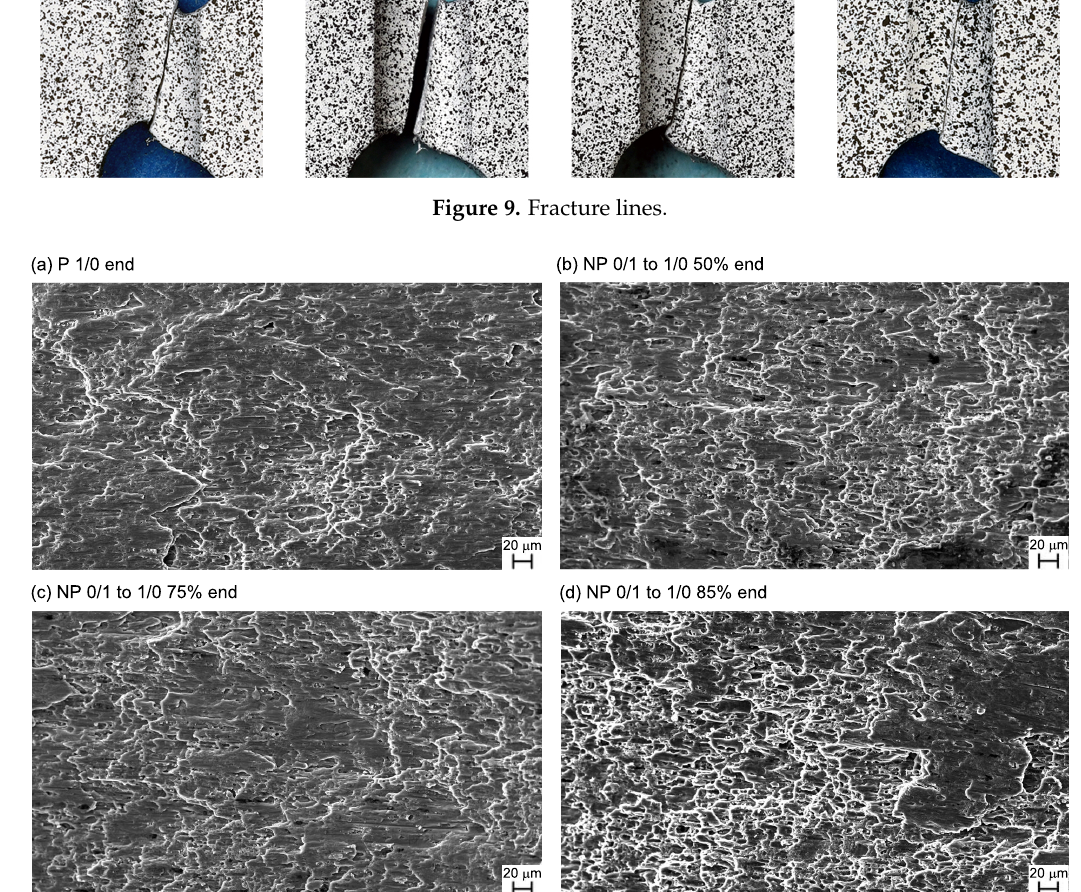
Figure 10. Scanning electron microscopy (SEM) pictures of the fracture